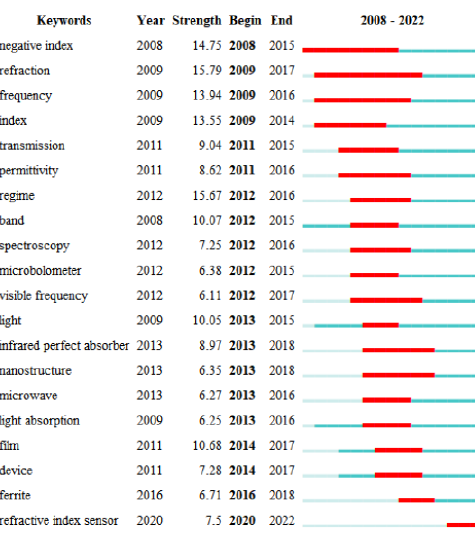
Figure 6. Top 20 keywords of metamaterial absorbers with the strongest citation bursts.